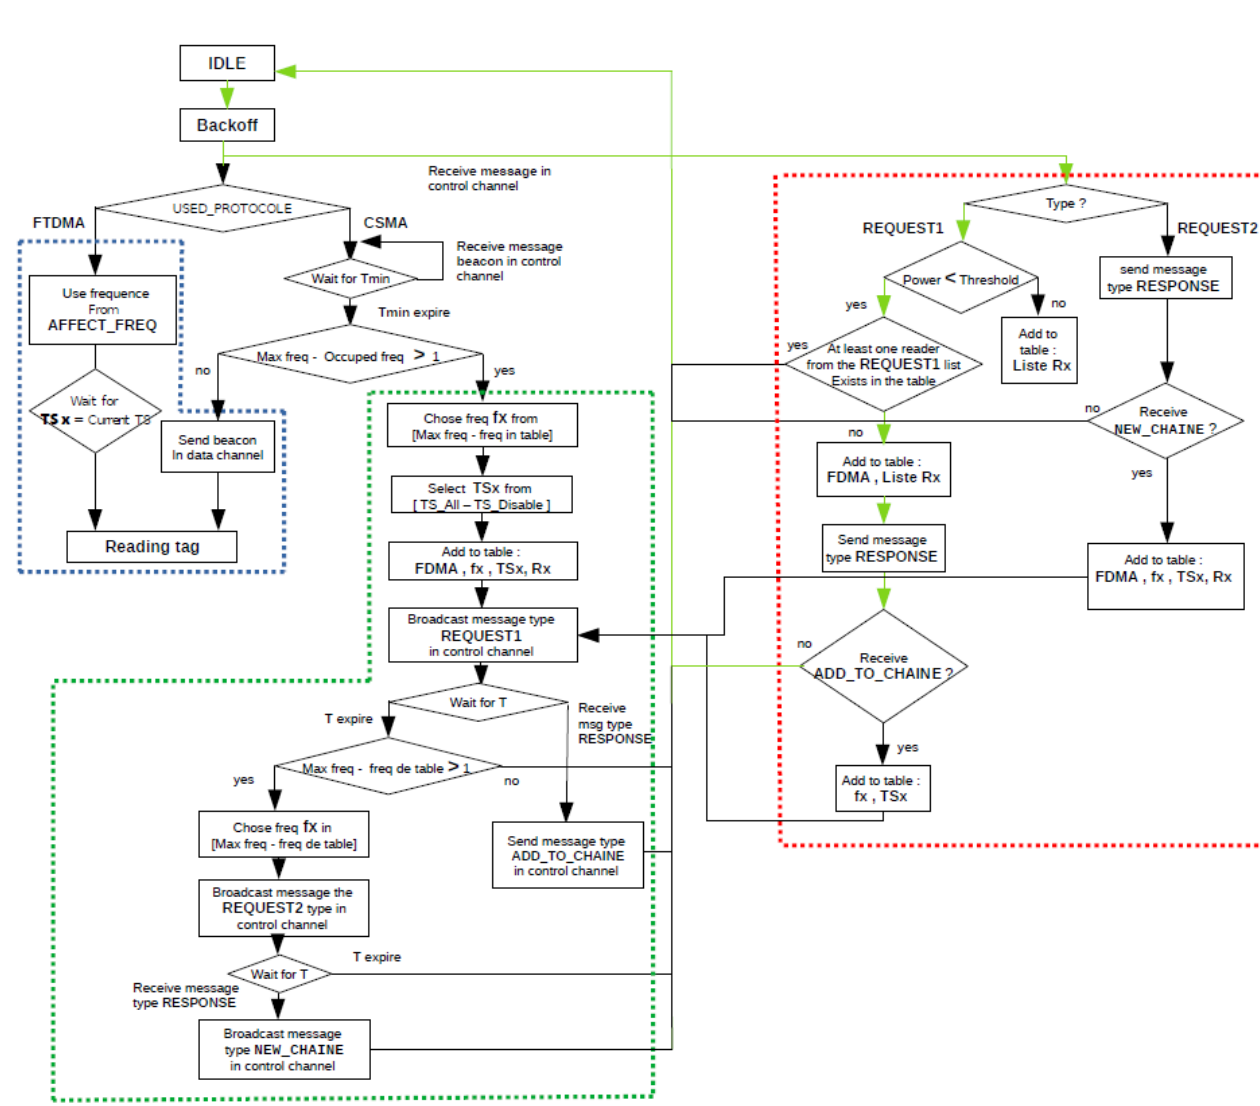
Figure A2. R2 Figure A2. R2 process.